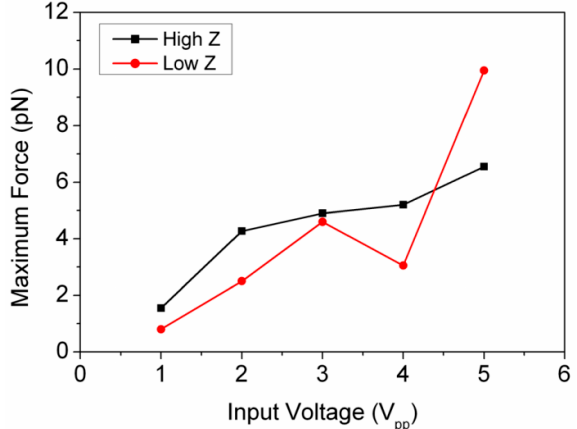
Figure 14. E stimated maximum acoustic radiation forces on Ø10 μm fluorescent polystyrene beads at different input